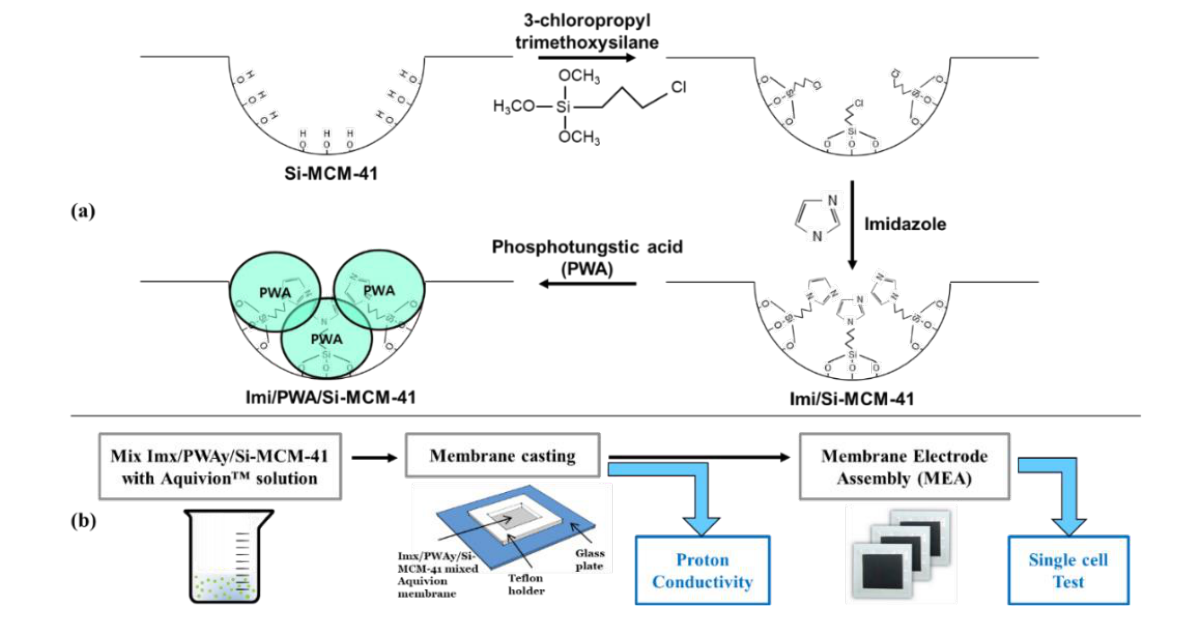
Figure 1. Summary of the order of ( a ) synthesizing Im(x)/PWA(y)/Si-MCM-41. ( b ) Membrane manufacturing and performance test.